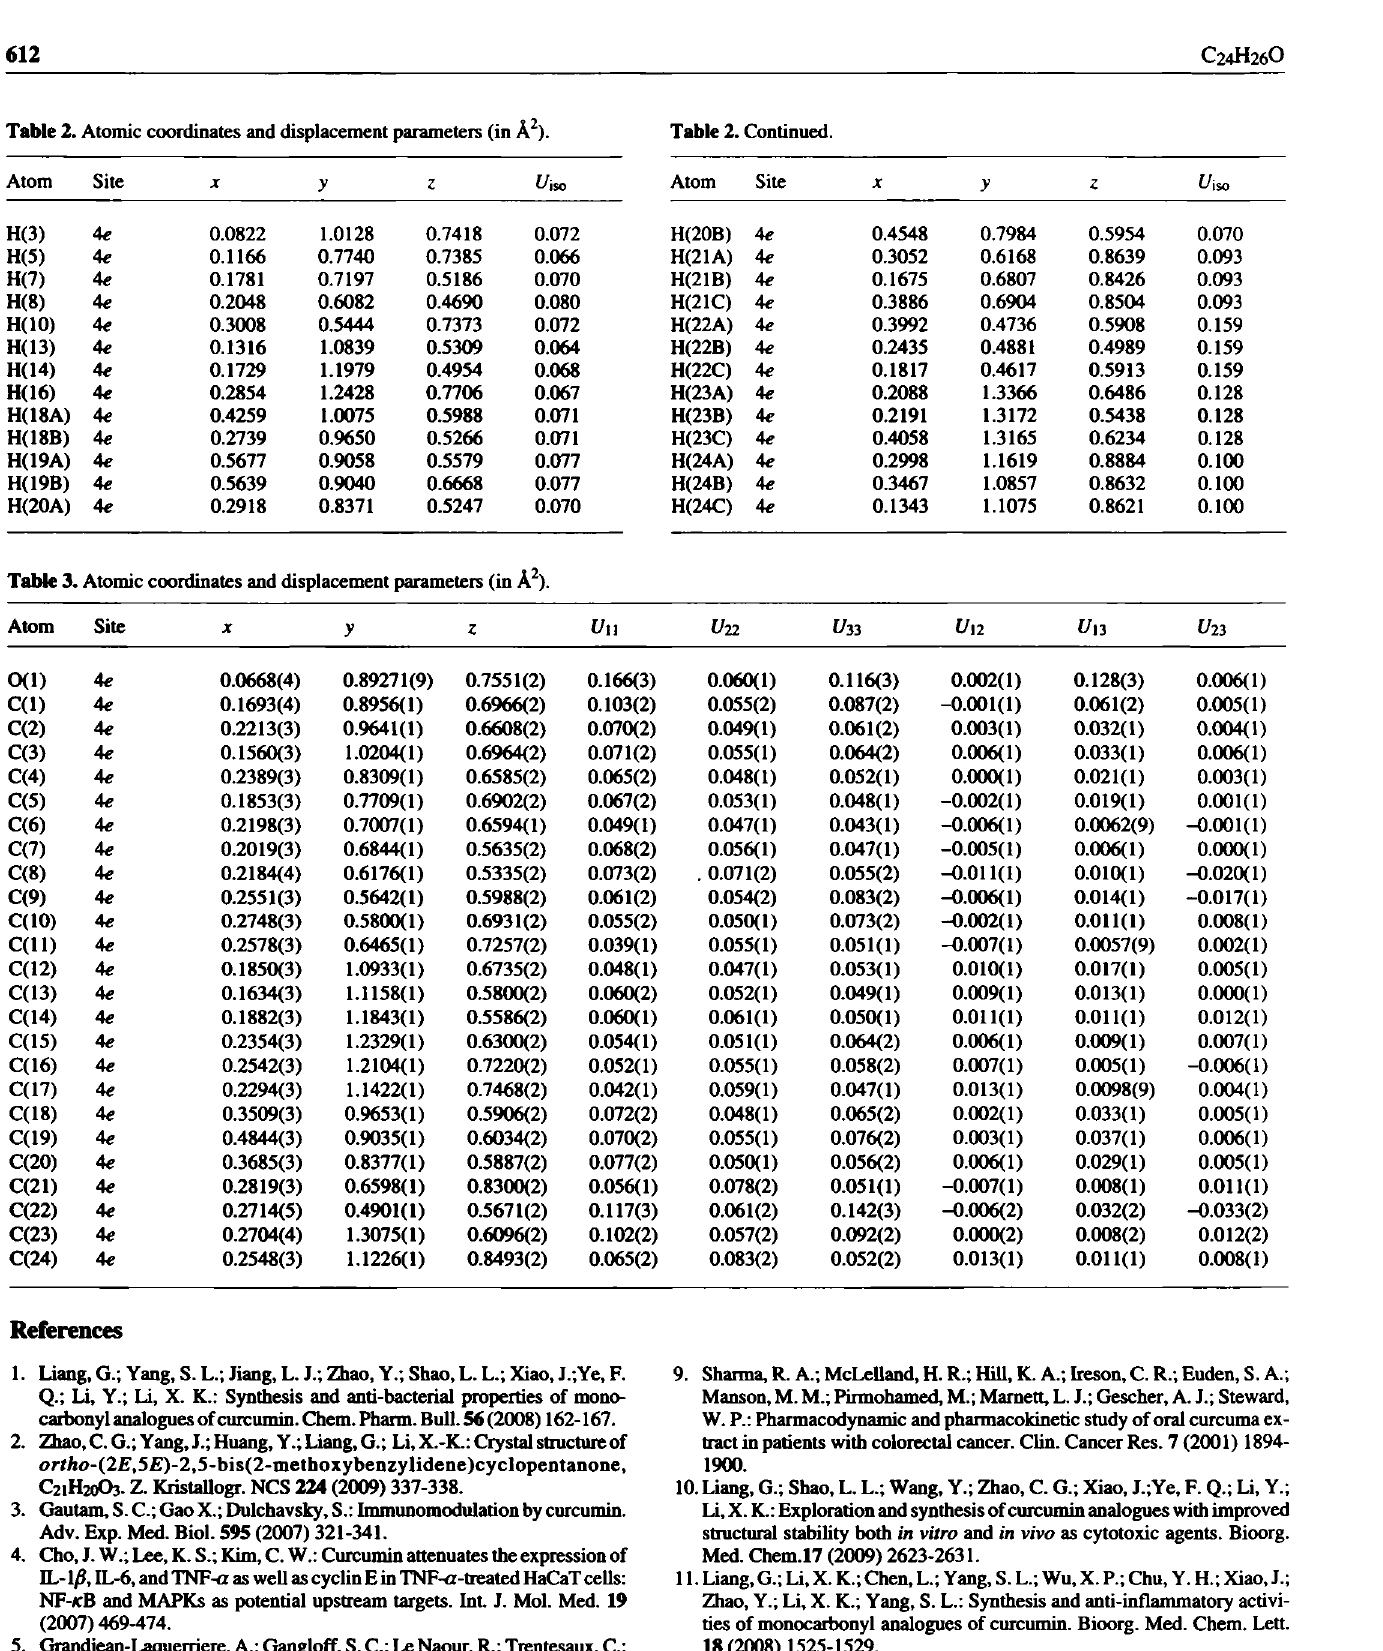
Table 2. Atomic coordinates and displacement parameters (in Â 2 ).